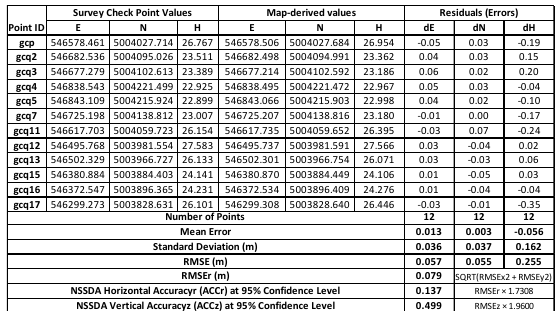
Table A2: Map Accuracy for the Single Strip ISO - Railway